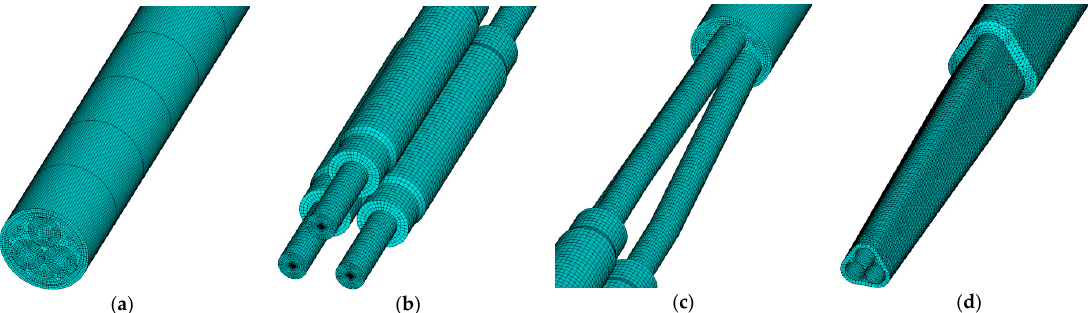
Figure 3. Mesh of each part in the three-core cable joint. ( a ) Cable; ( b ) Joint; ( c ) Connection region between cable and joint; ( d ) Air and armor wrap.